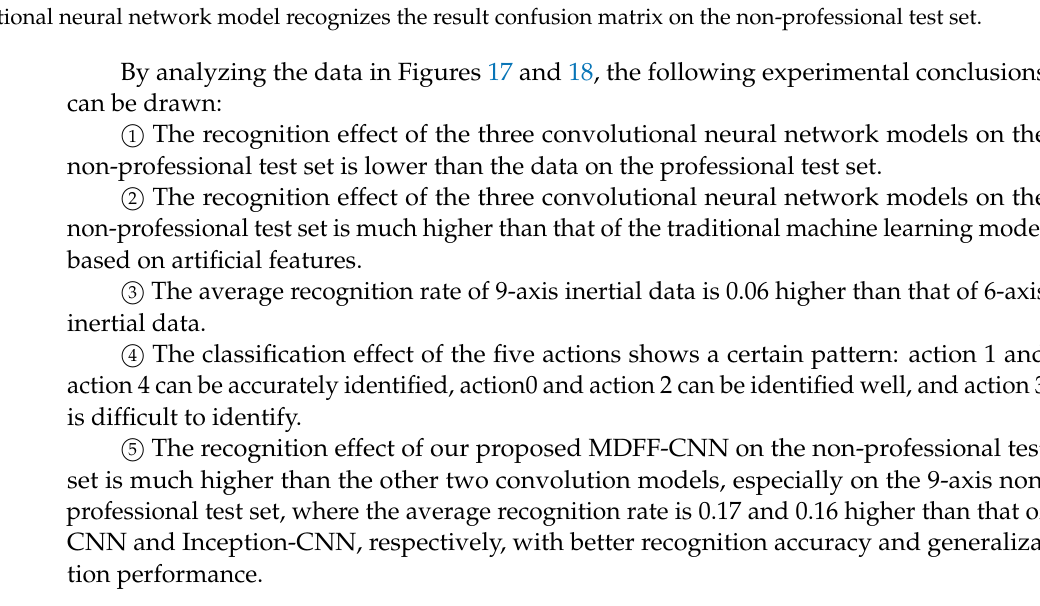
Figure 18. Convolutional neural network model recognizes the result confusion matrix on the non-professional test set.